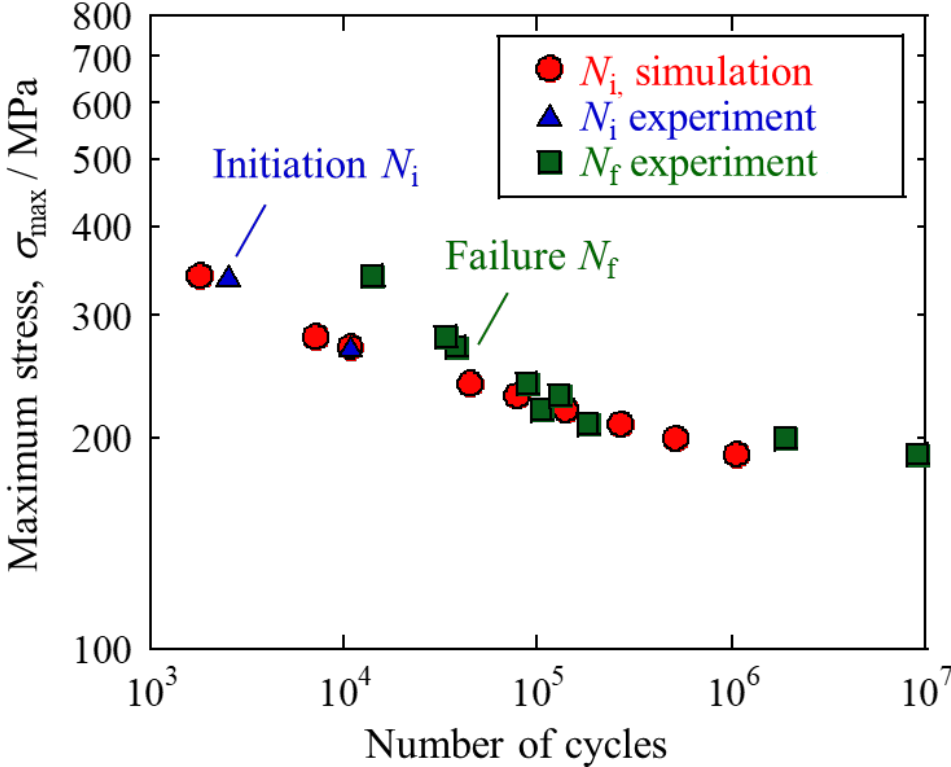
Figure 6. Predicted fatigue crack initiation life and experimental fatigue crack initiation and failure life taken from the literature [5].